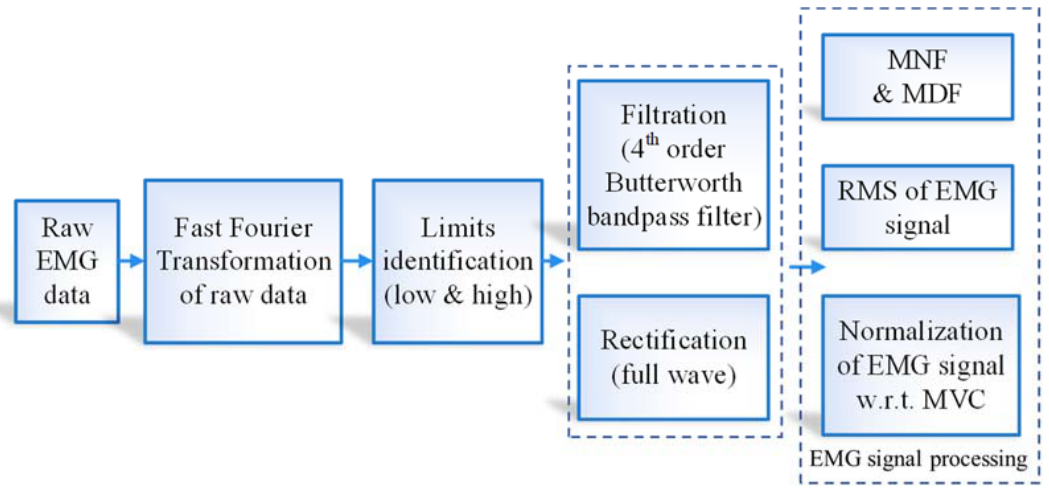
Figure 2. Flow chart for feature extraction of recorded EMG signals.